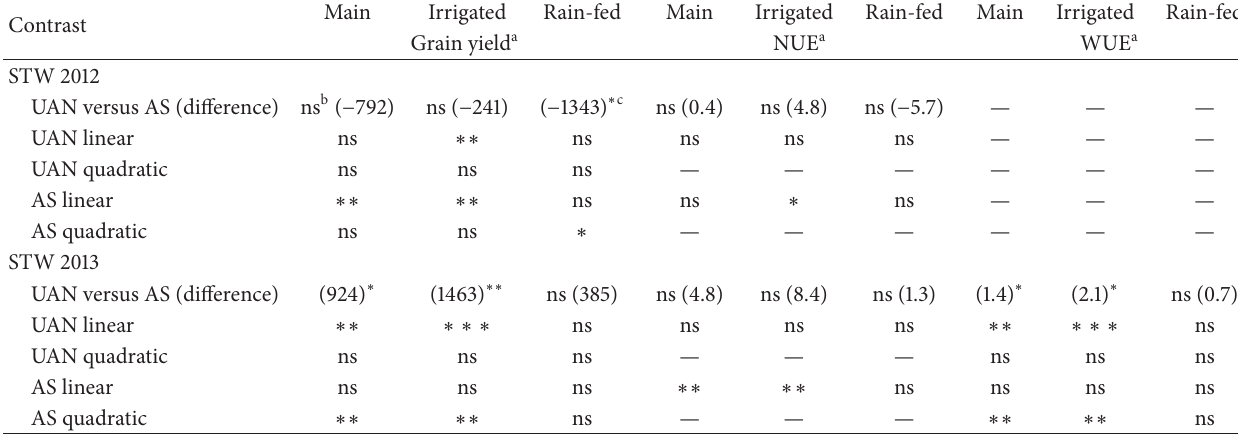
Table 6: Single degree-of-freedom contrast results for differences in treatment groupings for grain yield, N use efficiency (NUE), and water use efficiency (WUE) for Stillwater, OK (STW), in 2012 and 2013. Results listed under the “Main” column heading are the results of data pooled across irrigated and rain-fed treatments. Values in parenthesis are the difference in mean values for the group after the “versus” subtracted from the mean value of the group before the “versus.”